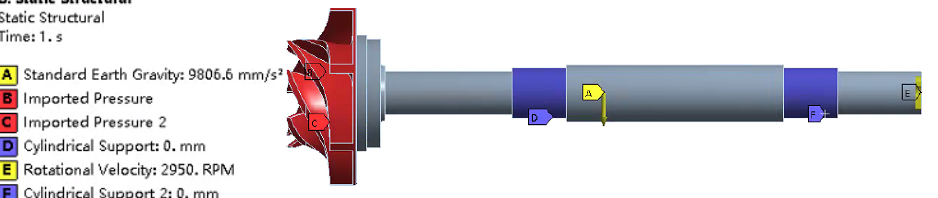
Figure 5. The constraint and load of the impeller rotor.